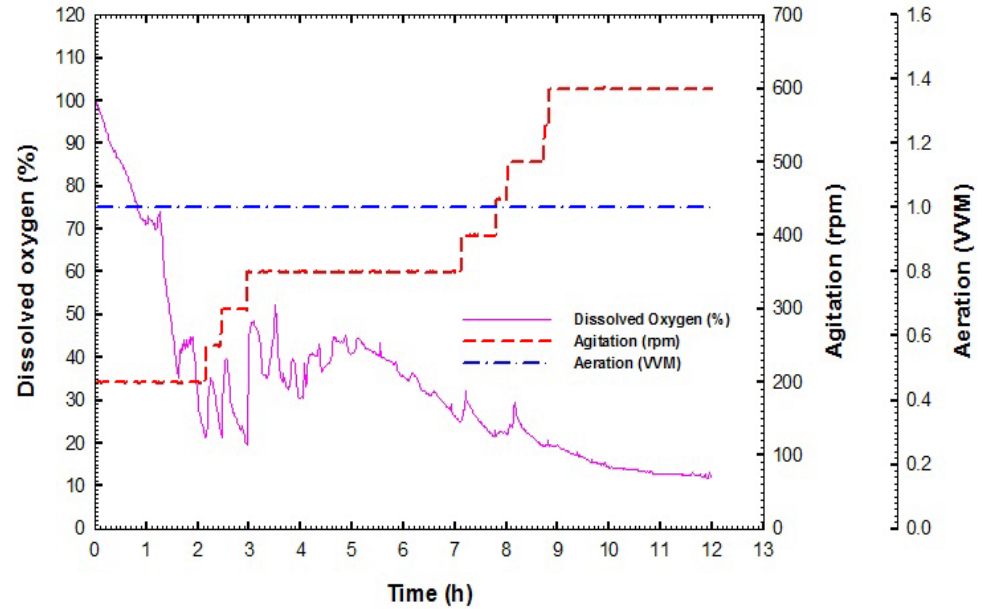
Figure 3. Dissolved oxygen, agitation, and aeration as a function of time during batch fermentation of Bacillus velezensis strain GB1.